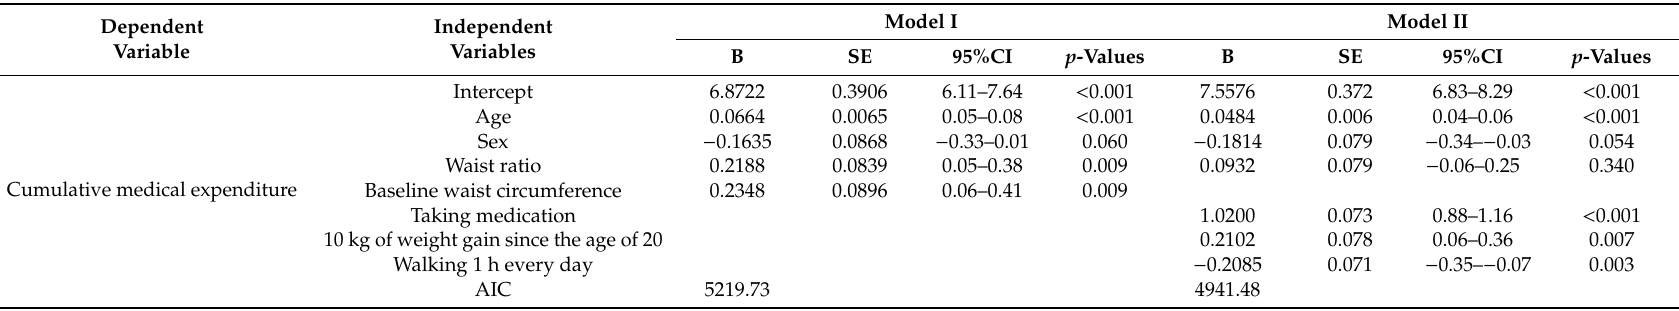
Table 2. Results of the Tobit regression analyses with individual 5-year cumulative outpatient and medication expenditure as the dependent variable.